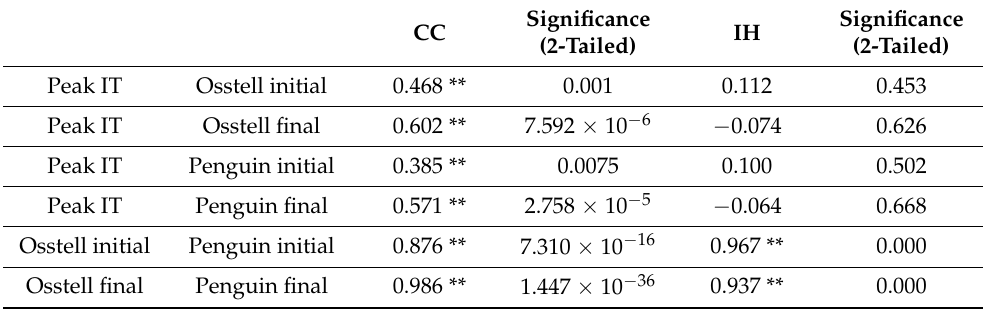
Table 7. Correlation coefficient between the different device measurements using Spearman’s rho correlation coefficient comparing the effect of the implant types CC and IH on the correlation (IT = insertion torque). ** The correlation is significant at the 0.01 level